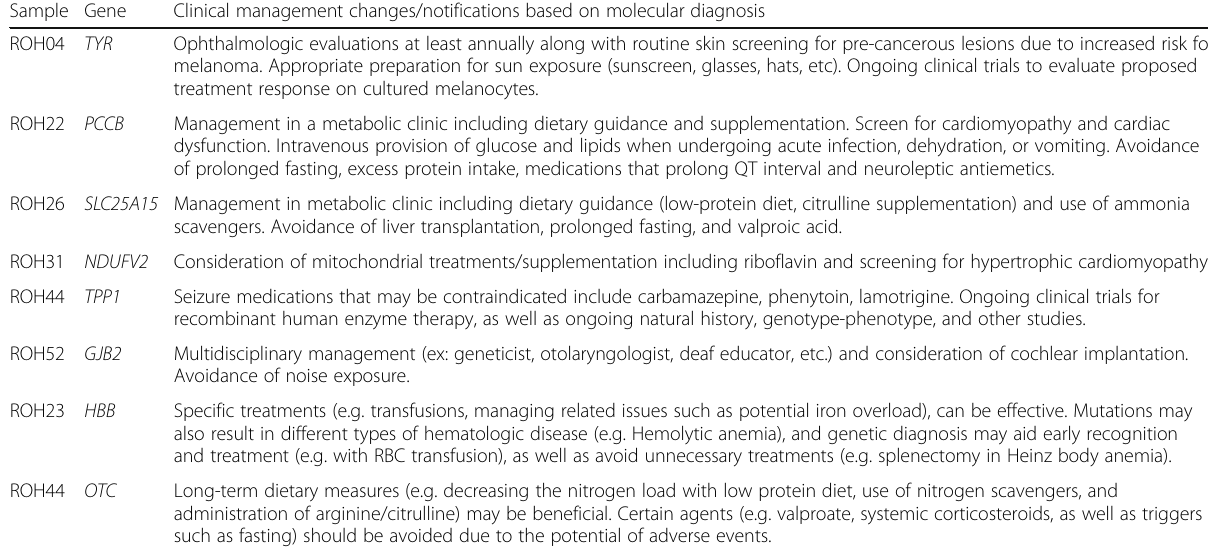
Table 3 Guideline-recommended clinical management changes associated with pathogenic or likely pathogenic mutations Sample Gene Clinical management changes/notifications based on molecular